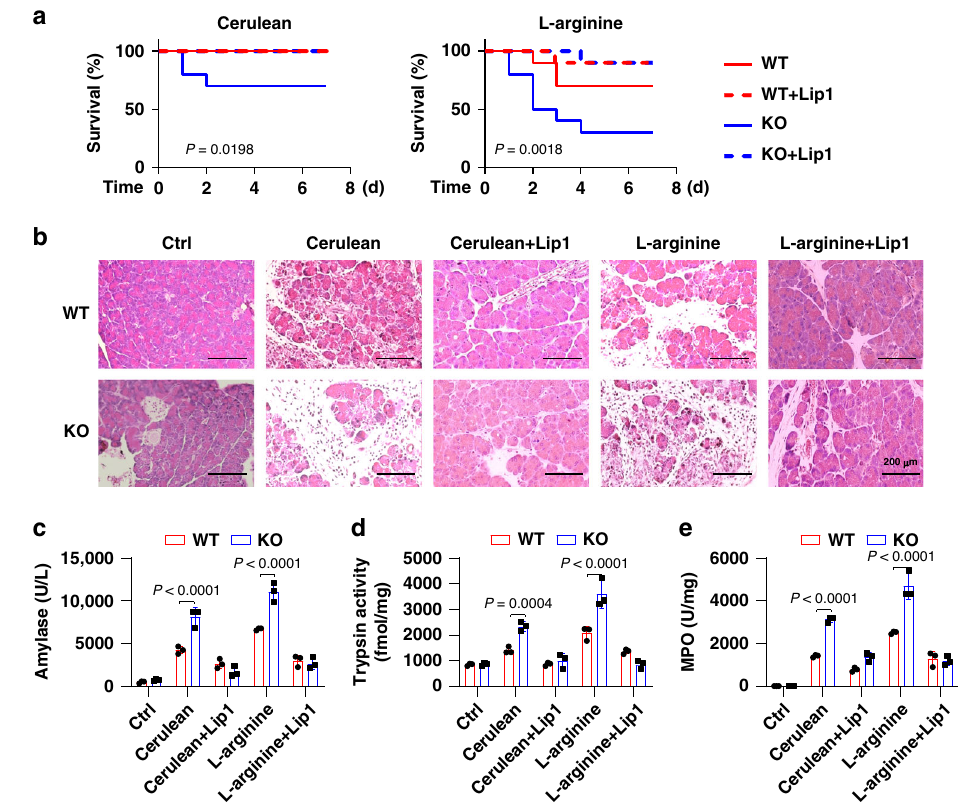
Fig. 1 Gpx4 depletion promotes experimental pancreatitis. a Survival of wild-type (WT) or Pdx1-Cre;Gpx4 − / − (KO) mice with cerulean- or L -arginine- induced pancreatitis with or without liproxstatin-1 (Lip1) treatment ( n = 10 mice/group; one-sided log-rank [Mantel – Cox] test). b – e In parallel, pancreas histology ( b ), plasma amylase activity ( c ), pancreatic trypsin activity ( d ), and pancreatic myeloperoxidase (MPO) activity ( e ) at 24 h were assayed ( n = 3 mice/group; two-way ANOVA with Tukey ’ s multiple comparisons test). Data in c – e are presented as mean ± SD. Data are from two or three independent